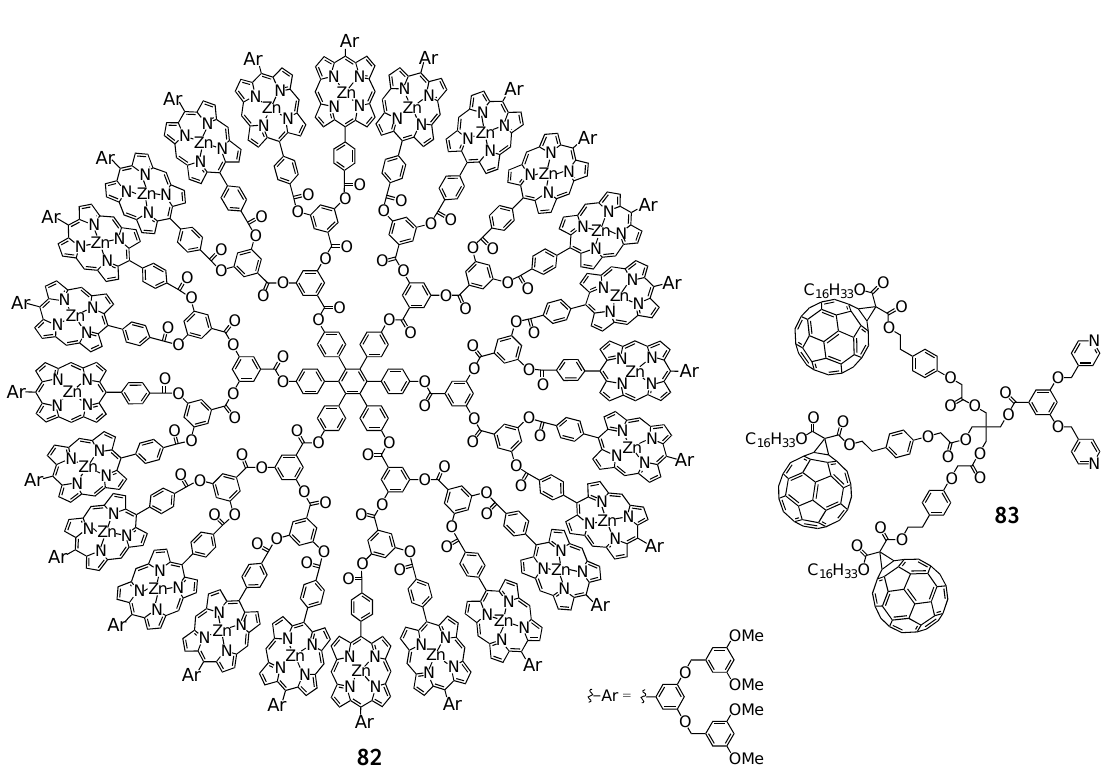
Figure 13. Polyporphyrin dendrimer 82 and bipyridine 83 for metal-ligand complexation